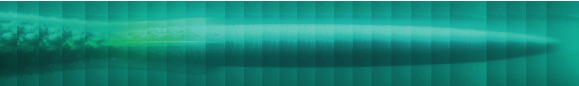
Figure 19: Supercavity profile after image mosaic.